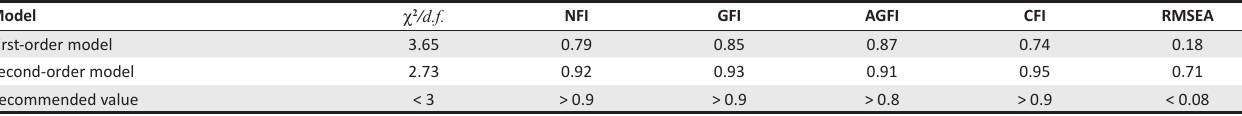
TABLE 3: Comparison of measurement models of e-loyalty. Model c 2 / d.f.